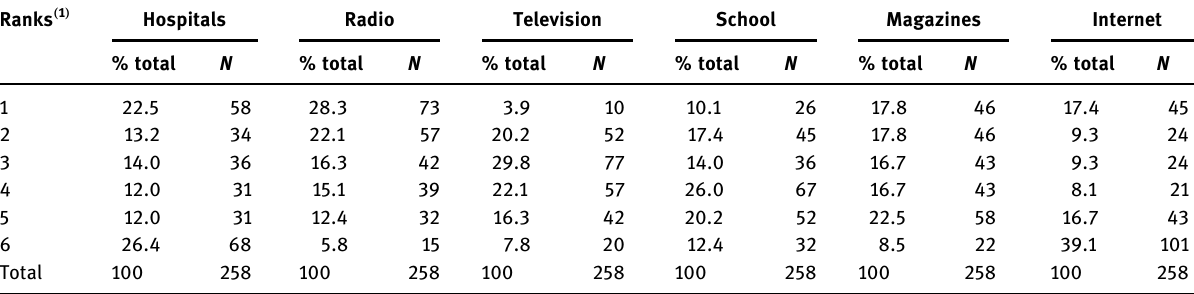
Table 3: Most appropriate means of communication to encourage the consumption of healthy food Ranks ( 1